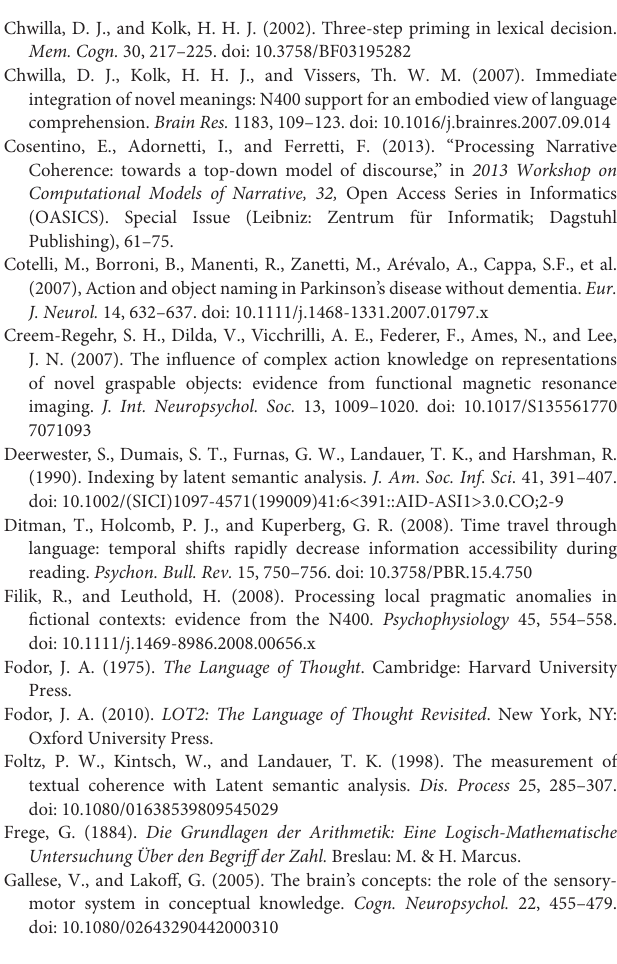
Supplementary Figure 1 | ERPs effects of Telic and NonTelic combinations presented in isolation. Grand average waveforms measured on the verb for Telic and NonTelic combinations are shown for nine centro-parietal channels, together with the topography of the negativity effect (NonTelic condition minus Telic condition). The waveforms show a negativity effect for NonTelic noun-verb combinations compared to Telic